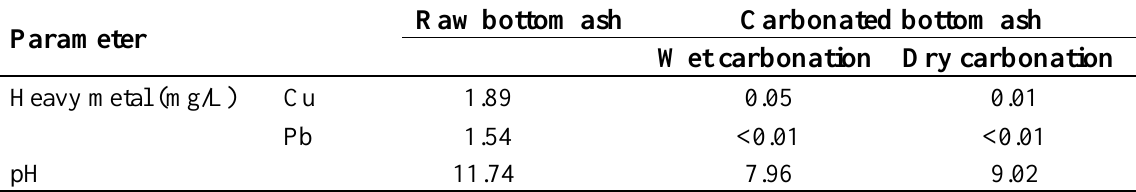
Table 1. Comparison of leaching concentrations (mg/L) of heavy metals and pH values between raw and carbonated bottom ash at wet (L/S = 5) and dry (L/S = 0.2) condition (modified from Ahn et al . [23] with permission of KSGE ).